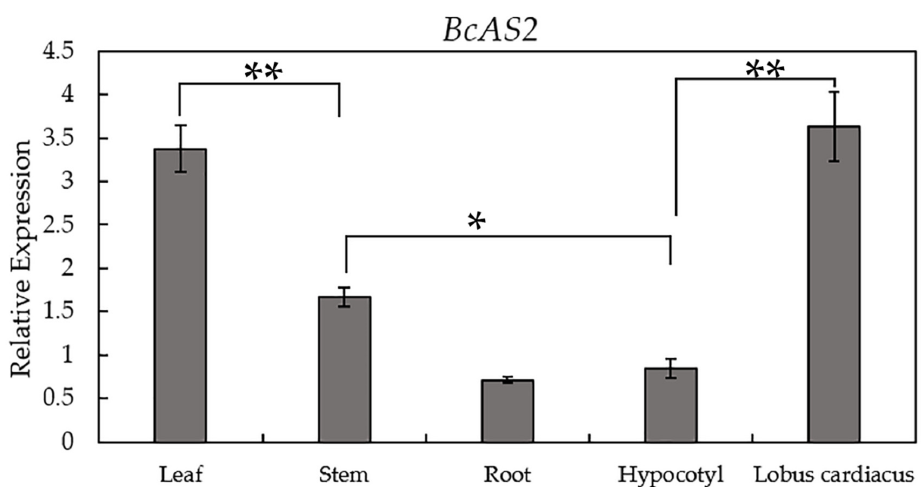
Figure 2. Expression patterns of BcAS2 in different tissues. The expression level of BcAS2 in leaf, stem, root, hypocotyl, lobus cardiacus of 1-month-old pak choi cultivar “NHCC001”. The data represent the average of the three replicates, and the error bars represent the standard deviation between the replicates. ** and * mean significant differences between different tissues, *, p < 0.05, **, p < 0.01.